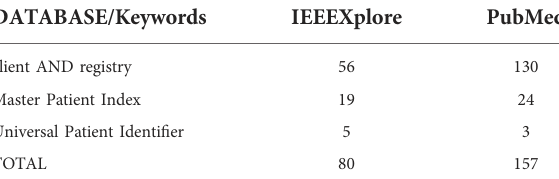
TABLE 1 Summary of results from scholarly data base searches.